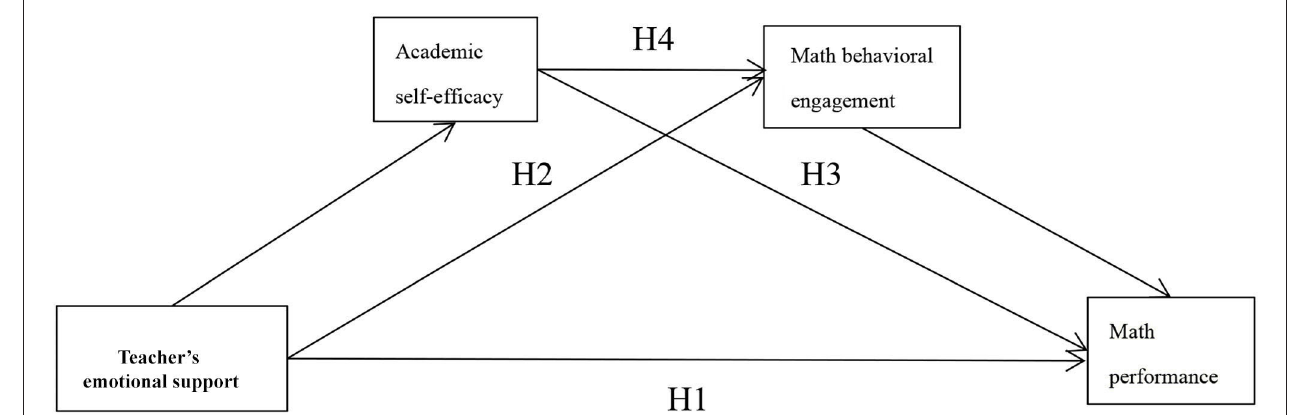
FIGURE 1 | Hypothesized